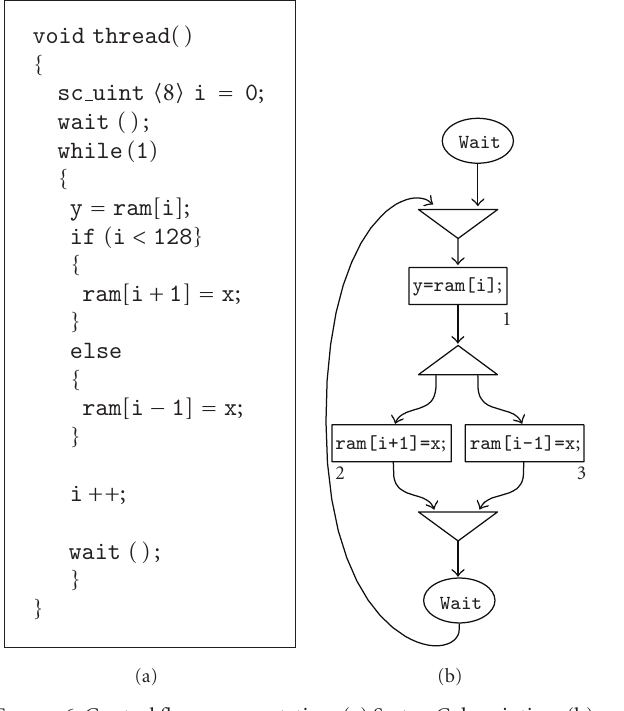
Figure 6: Control flow representation. (a) SystemC description, (b) control flow